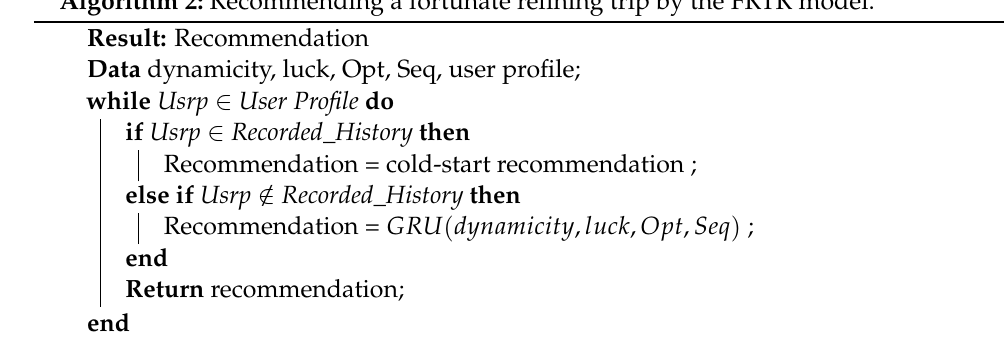
Algorithm 2: Recommending a fortunate refining trip by the FRTR